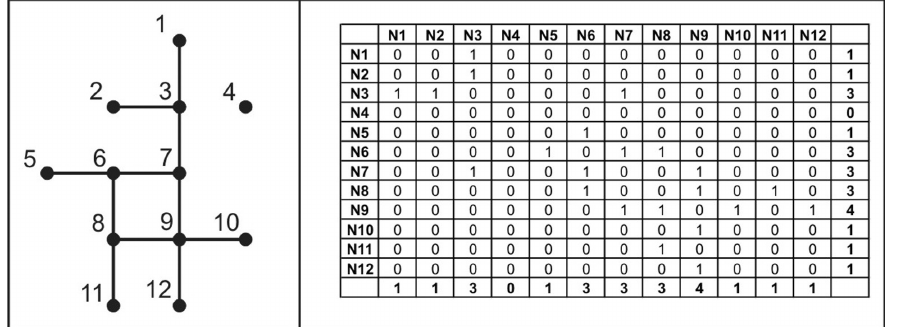
Fig. 4. Incidence matrix (connections between nodes) for a graph example. Source: own